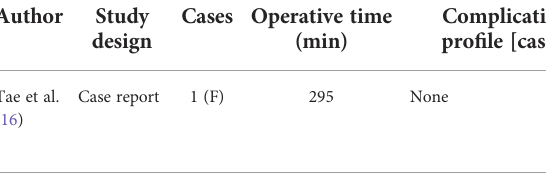
(Figure 3A1) or circumareolar incision (Figure 3A2). The chest approach is the most widely used method of endoscopic LND.